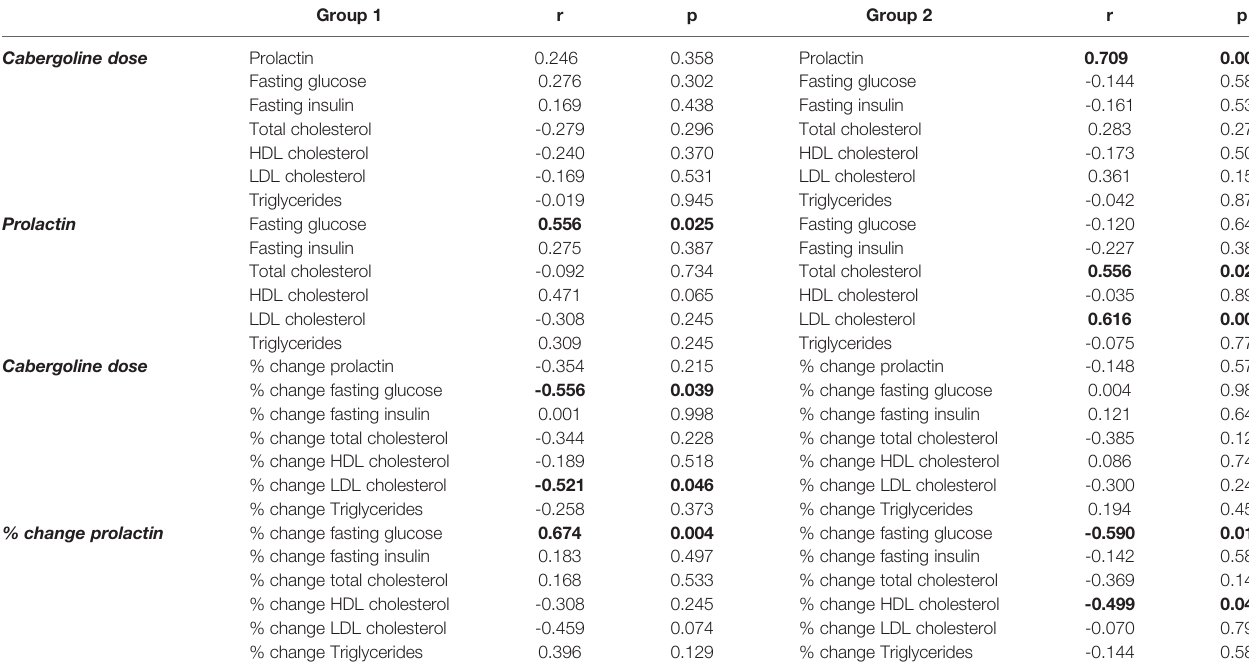
TABLE 3 | Correlation study: impact of cabergoline dose and prolactin levels on metabolic parameters and their % change through the study.